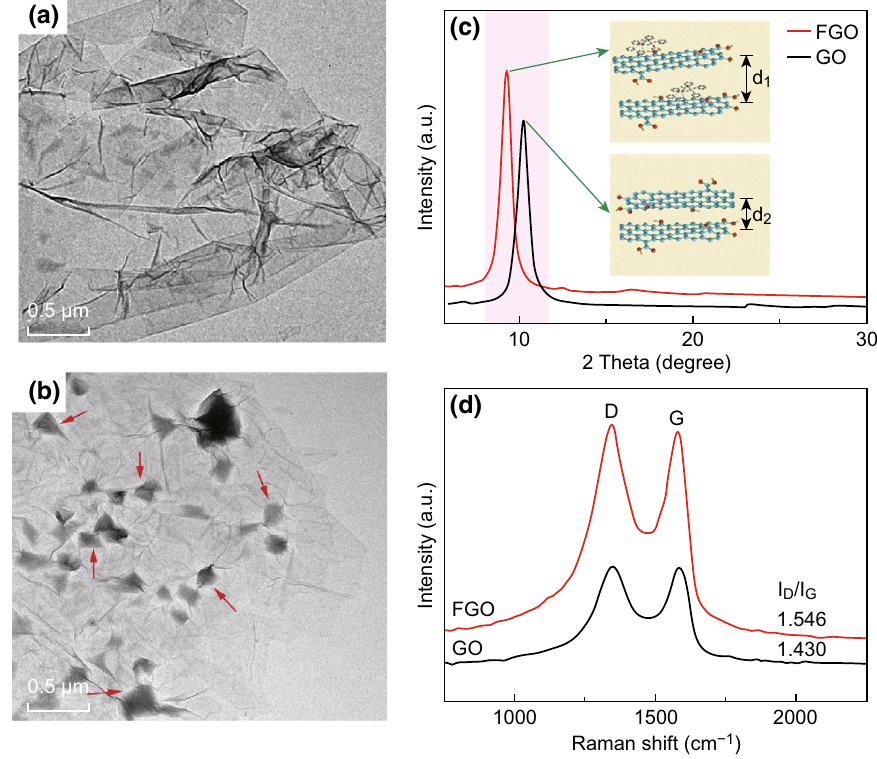
Fig. 2 TEM images of a GO and b FGO. c XRD patterns and d Raman spectra of GO and